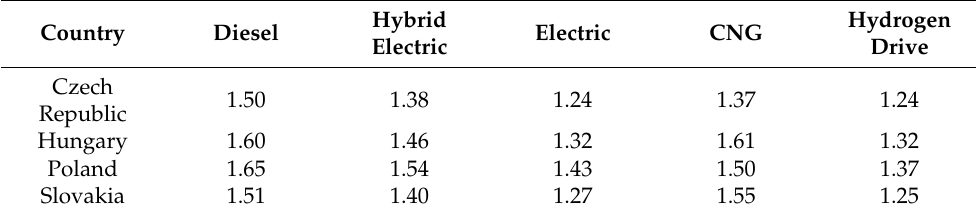
Table 15. Cost of a vehicle-kilometer of maxi buses (12 m) with different drive types in the V4 countries, calculated on the basis of the last year of operation (2035) ( € ).